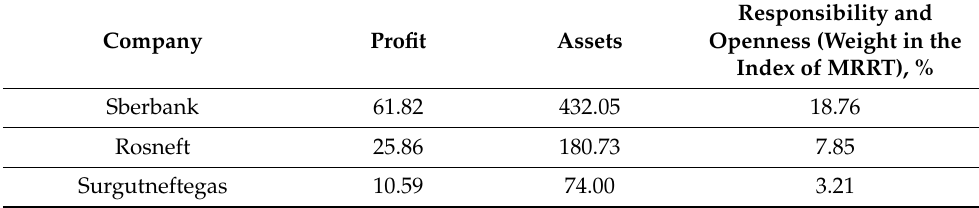
Table A5. Expected values of three